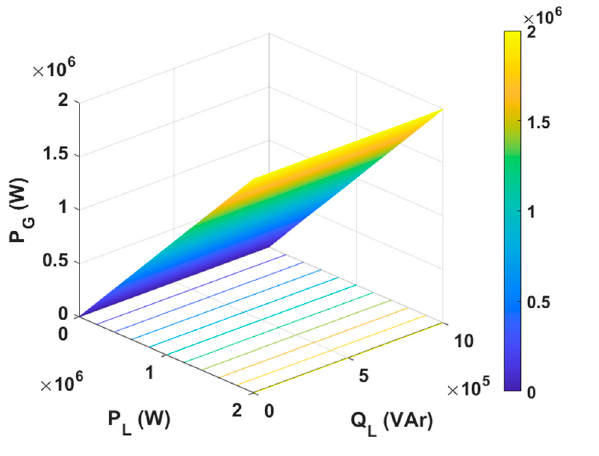
Figure 8. AC control characteristic.